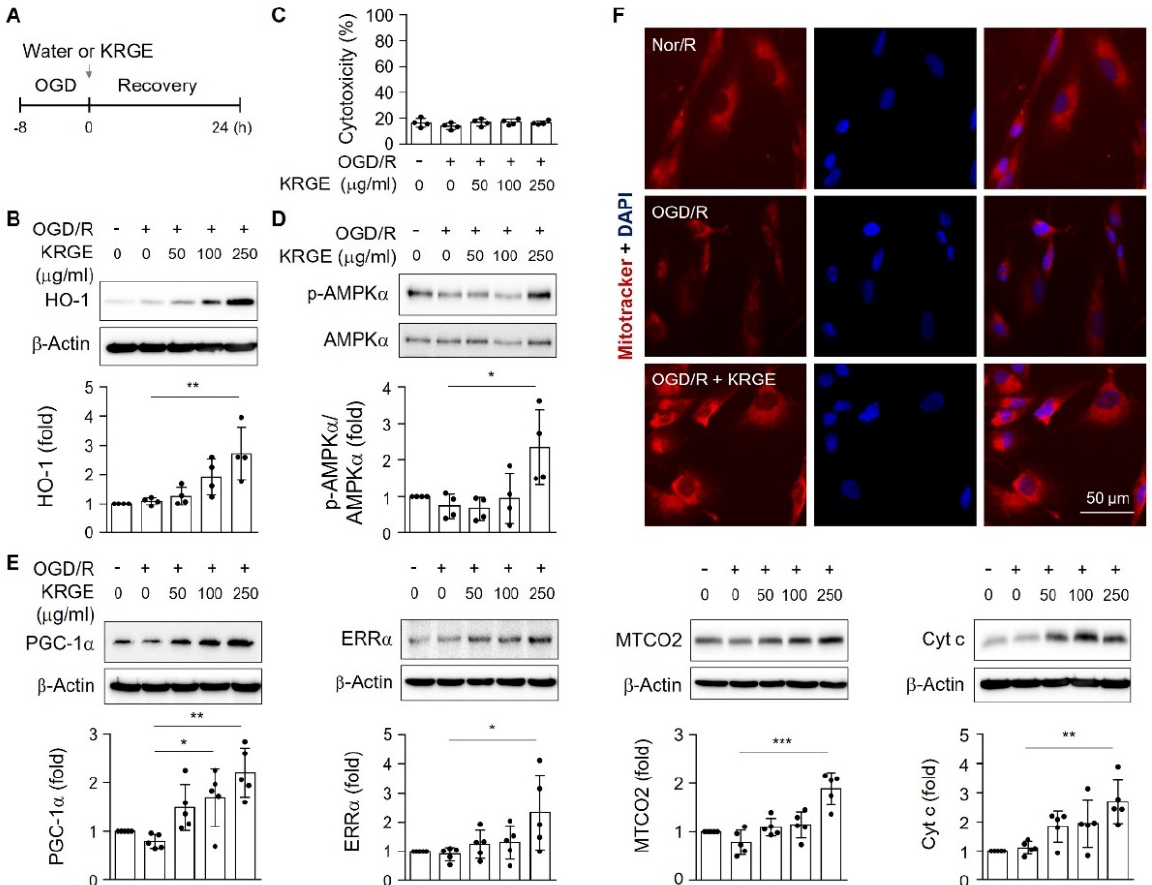
Figure 2. KRGE induces expression of HO-1 and mitochondria-related proteins in human astrocytes. ( A ) Human astrocytes were subjected to oxygen-glucose deprivation (OGD) for 8 h and subsequently treated with KRGE for 24 h. ( B ) Lysed cells obtained from various concentrations of KRGE were collected. HO-1 protein levels were detected by Western blotting ( n = 4 per group). ( C ) Human astrocytes were subjected to various KRGE concentrations in OGD/R conditions, and cytotoxicity was measured ( n = 4). ( D , E ) Lysed cells obtained from various concentrations of KRGE were collected. Indicated protein levels were detected by Western blotting ( n = 4 or 5 per group). * p < 0.05; ** p < 0.01; *** p < 0.001. ( F ) Representative image of the Mitotracker (red) and DAPI (blue) staining in human astrocytes ( n = 5 per group). Scale bar = 50 μ m.